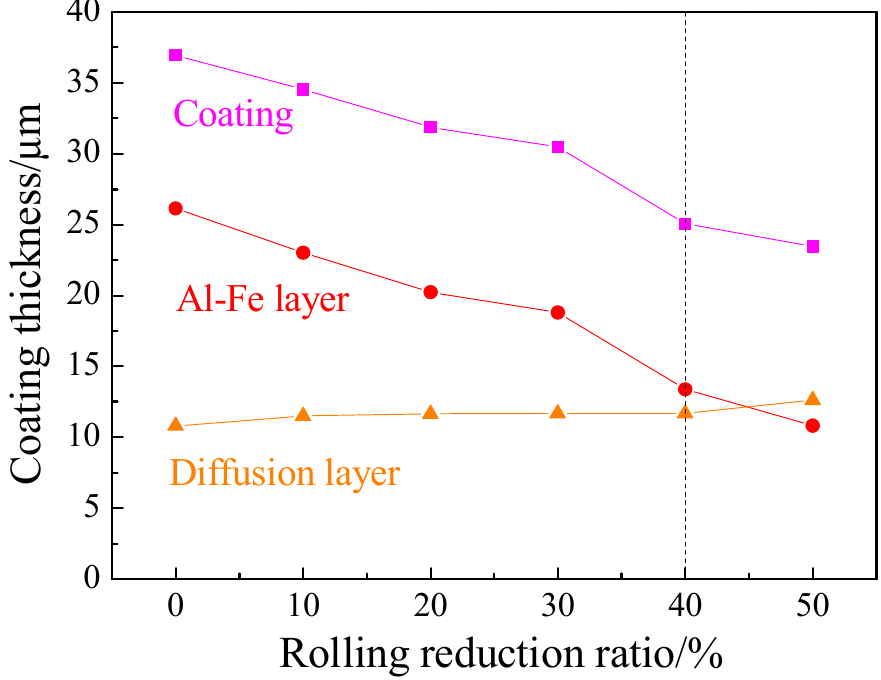
Figure 13. Thickness of AS60/60 coating at different reduction ratios at TAUS = 930 °C for 5 min. When the AS60/60 coatings deformed without reduction were austenitized, the map- scanned zone clearly consisted of a Fe 2 Al 5 layer, a FeAl layer, a Fe 2 Al 5 layer, a diffusion layer, and the steel substrate (Figure 14). In the Fe 2 Al 5 layer, the Al and Fe concentrations were relatively stable, the Al concentration was large, but the Si concentration was low.